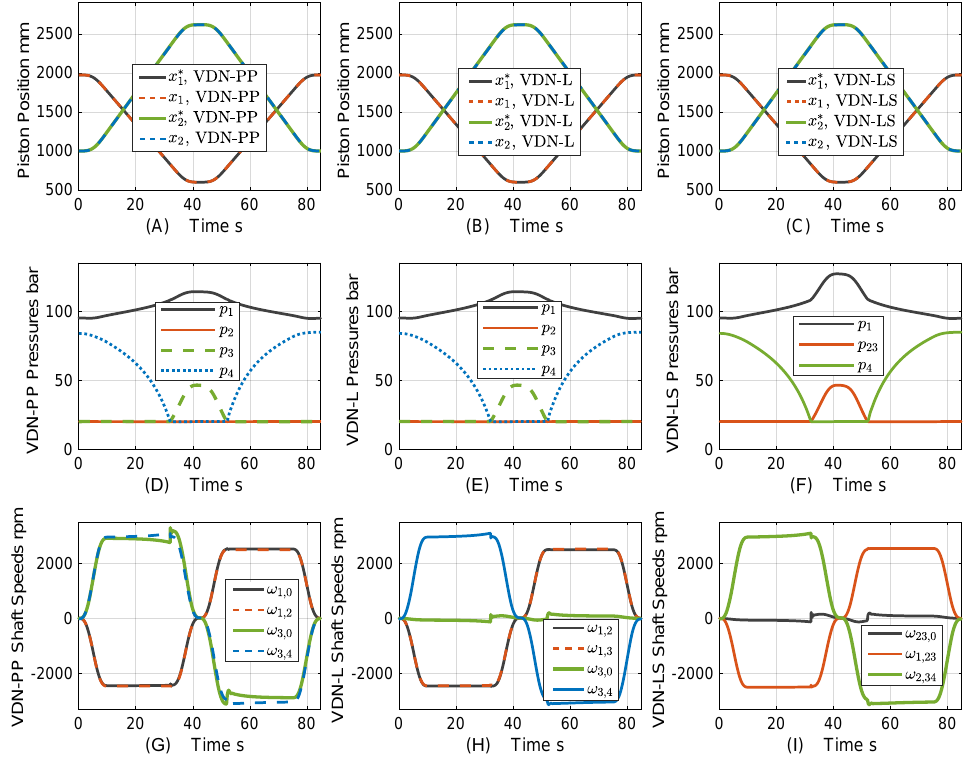
Figure 21. ( A ) Reference and actual cylinder positions for VDN-PP case; ( B ) reference and actual cylinder positions for VDN-L case; ( C ) reference and actual cylinder positions for the VDN-LS case; ( D ) chamber pressures for the VDN-PP case; ( E ) chamber pressures for the VDN-L case; ( F ) Chamber pressures for the VDN-LS case; ( G ) VsD shaft speeds for the VDN-PP case; ( H ) VsD shaft speeds for the VDN-L case; ( I ) the VsD shaft speeds for the VDN-LS case. The corresponding input and output powers as well as the individual loss